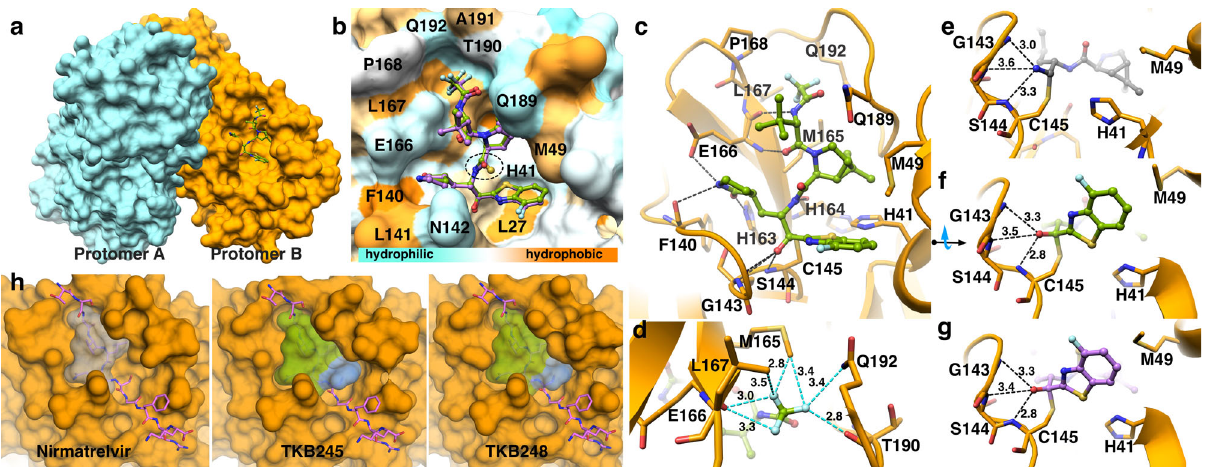
Fig. 4 | Co-crystal structures of TKB245 and TKB248 with SARS-CoV-2 M pro . a OverviewofM pro dimerincomplexwithTKB245.MolecularsurfaceofprotomerA colored in cyan and protomer B in orange. b Superimposition of TKB245 in green onto TKB248 in purple exhibits identical binding mode. M pro binding pocket is colored according to hydrophobicity scale. Hydrophobicity of the binding pocket isrepresentedbytheintensitiesoforangecolorsuchashydrophobicresidues:Leu- 27andPhe-140asshowninorange.PolarorchargedresiduessuchasGlu-166,Gln- 189 are shown in light blue. c Binding mode and hydrogen bond network in M pro complexed with TKB245. Cartoon representation of the crystal structure of M pro is shown in orange complexed with TKB245 (green stick). Hydrogen bonds are indi- catedasblackdashedlines. d Topviewfocusedontri fl uoromethyl(P4)groupwith